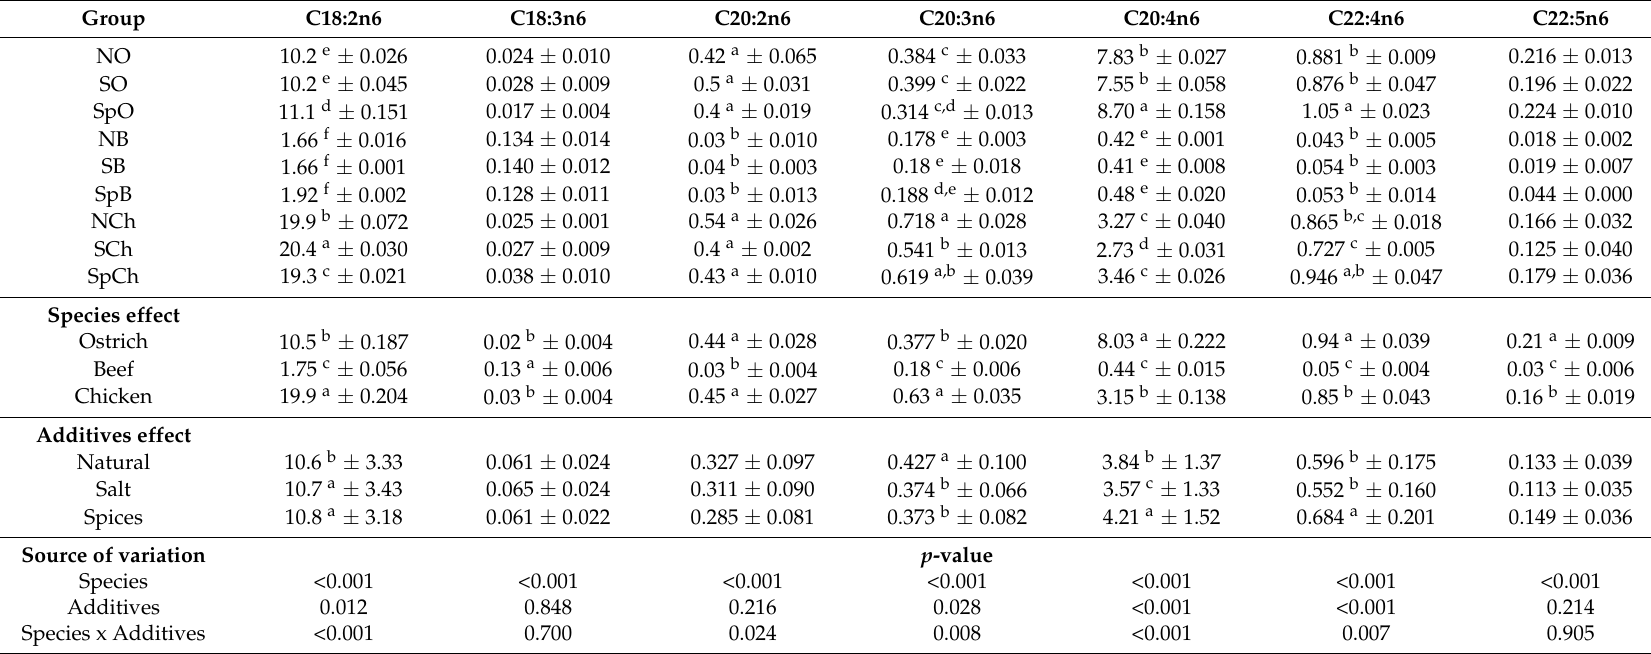
Table 6. Polyunsaturated fatty acid n -6 group composition in dried meat (%) (mean ±